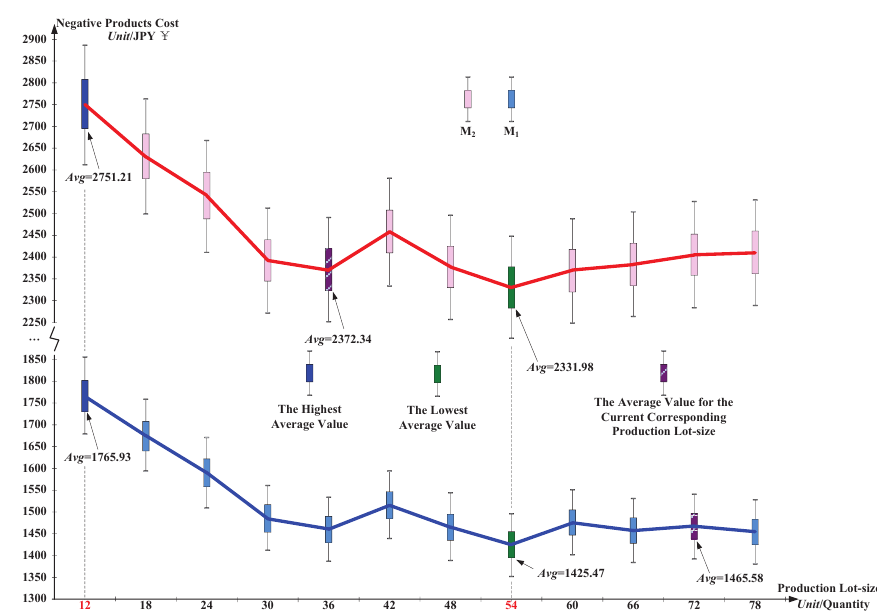
Fig. 8. Negative products cost of a unit part by regulating production lot-size.